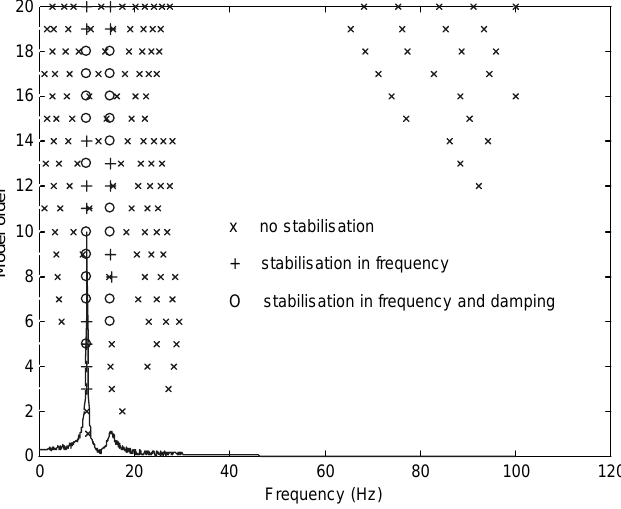
Fig. 5. Stability Plot Without Exponential